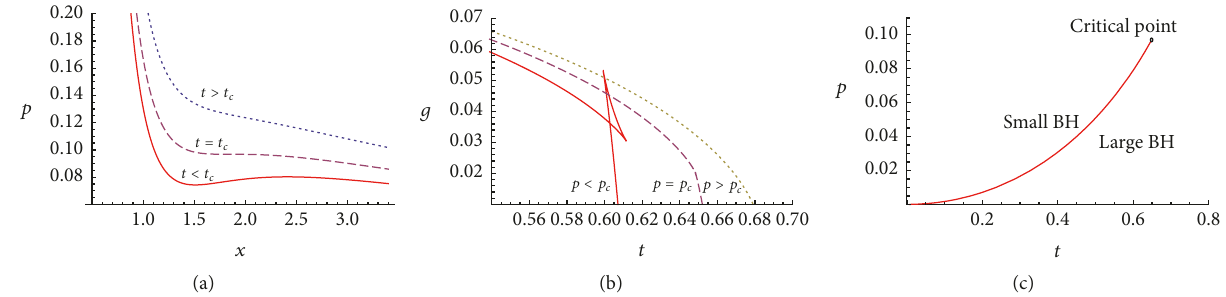
Figure 5: Born-Infeld AdS black holes for 𝑑 = 5 , 𝑤 2 = −0.25 , and 𝑤 3 = 0.1 . (a) The 𝑝 − 𝑥 diagram. The dashed curve represents critical isotherm at 𝑡 = 𝑡 𝑐 . The dotted and solid curves correspond to 𝑡 > 𝑡 𝑐 and 𝑡 < 𝑡 𝑐 , respectively. (b) The 𝑔 − 𝑡 diagram. The solid curve represents 𝑝 < 𝑝 𝑝 > 𝑝 𝑝 = 𝑝 𝑐 , the dotted curve correspond to 𝑐 , and the dashed curve is for 𝑐 . We observe standard swallowtail behavior. (c) The 𝑝 − 𝑡 diagram, showing the coexistence line of SBH/LBH phase transition terminating at a critical point. These plots are analogous to typical behavior of the liquid-gas phase transition of the VdW fluid.